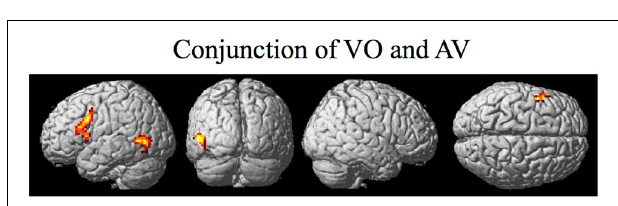
FIGURE 5 | Brain activity that was significant for both (conjunction) the VO and the combined AV conditions thresholded at pFDR < 0.05